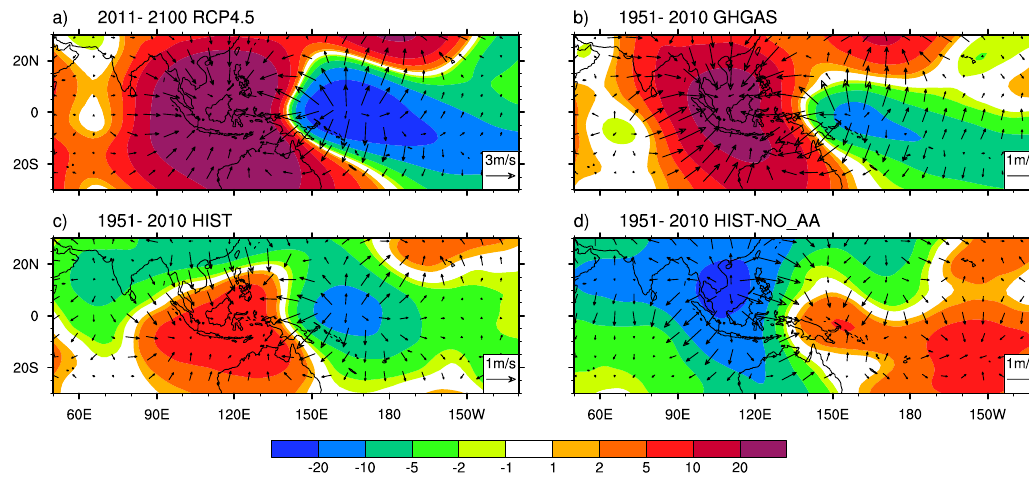
Fig. 16. Ensemble-mean DJFM trends of velocity potential (10 5 m 2 s − 1 century − 1 ) and divergent wind vectors (ms − 1 century − 1 ) at 200hPa, from (a) RCP4.5 (2011–2100), (b) GHGAS (1951–2010), (c) HIST (1951–2010), (d) HIST minus NO AA (1951–2010). The largest vector is shown in the lower-right corner of each panel; note different scaling of vectors in